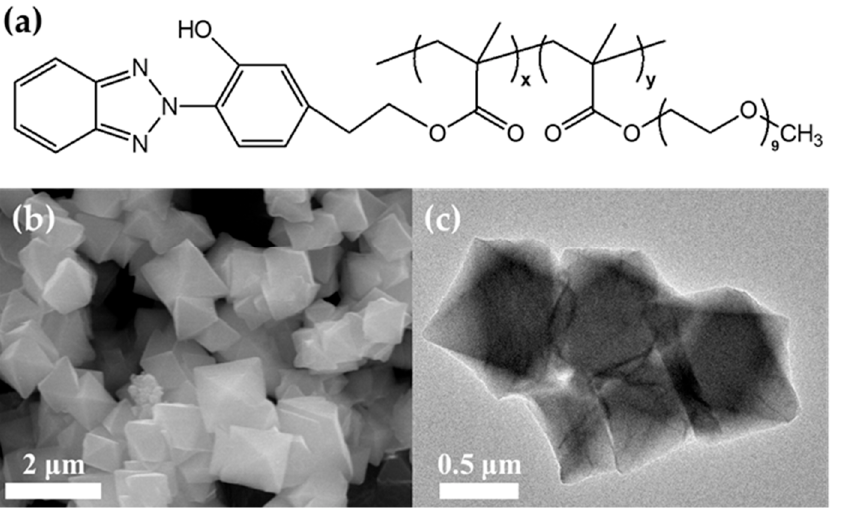
Figure 1. ( a ) Chemical structure of the PBE comb copolymer. ( b ) SEM and ( c ) TEM images of the synthesized MOF-808 nanoparticles. synthesized MOF-808